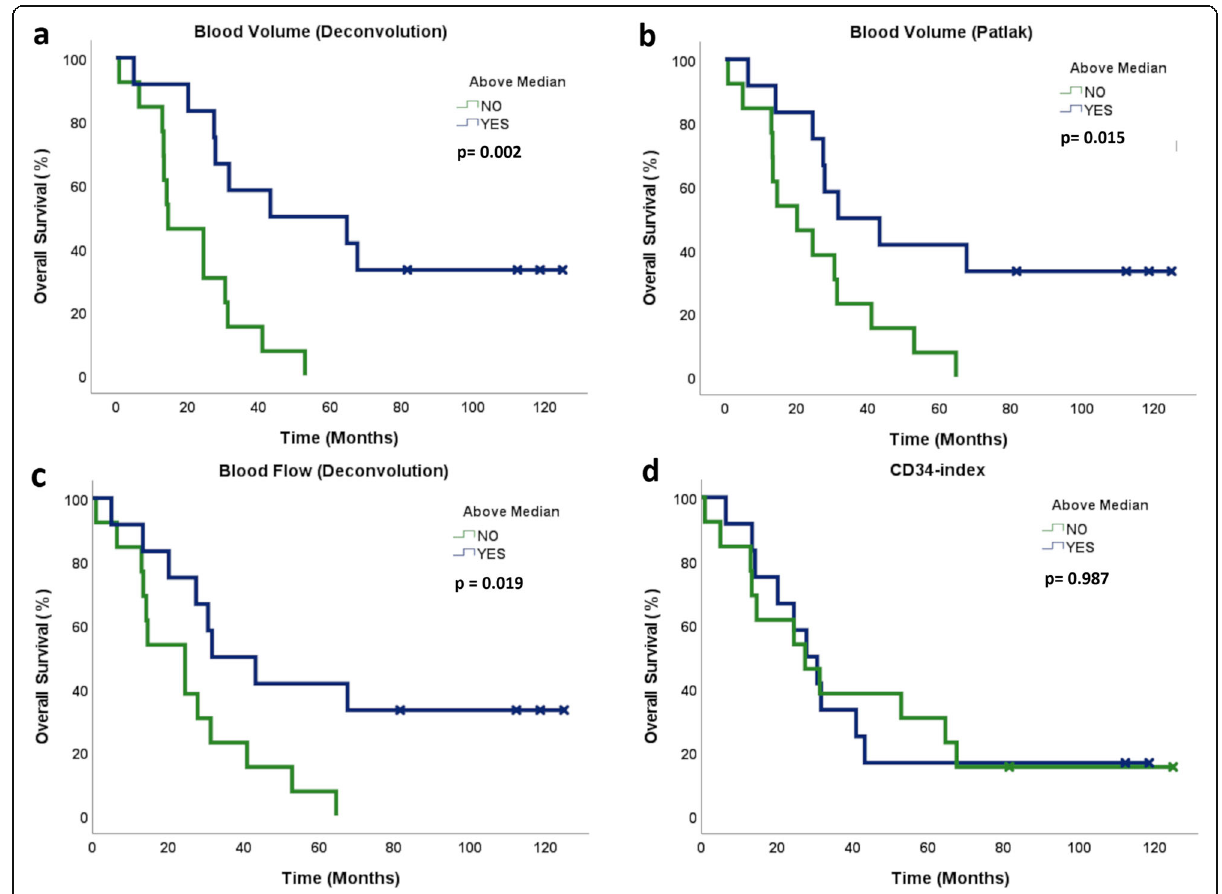
Fig. 3 Kaplan-Meier curves for overall survival for high versus low (a) BV deconv , (b) BV Patlak , (c) BF deconv , and (d) CD34-index in tumor, respectively, demonstrating favourable survival outcome for high BV deconv , BV Patlak , and BF deconv , whereas CD34-index was not associated to survival outcome. BV